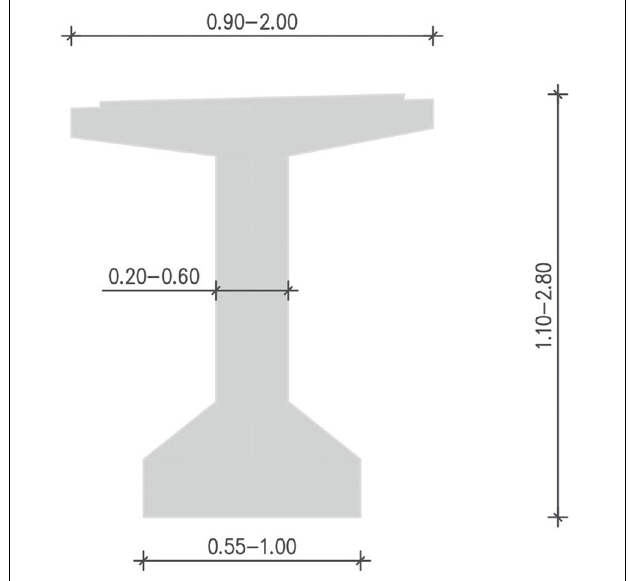
FIGURE 1 | Dimensional ranges of the dataset’s beams (all measurements in